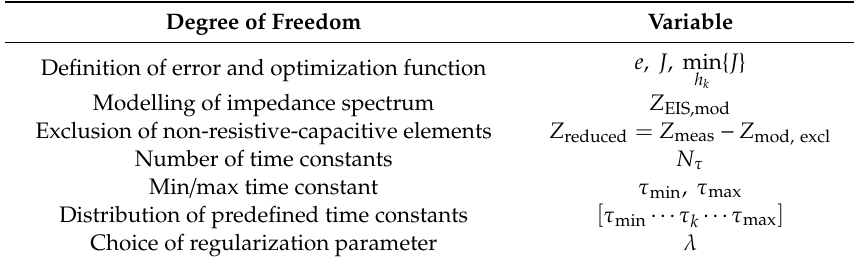
Table 3. Degrees of freedom and variables of distribution of relaxation times (DRT)